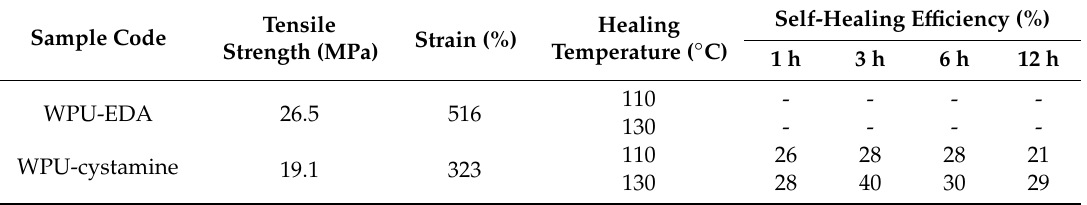
Figure 8. Disintegration of WPU films via the exchange reaction with 2-mercaptoethanol: ( a ) photographs; ( b ) schematic.